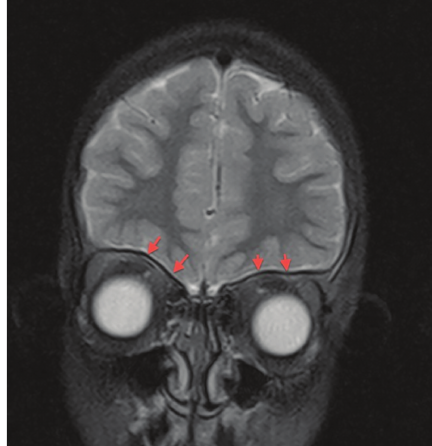
Figure 2: Coronal T2WI FSE. There is diffuse hypointense dural thickening (red arrows).